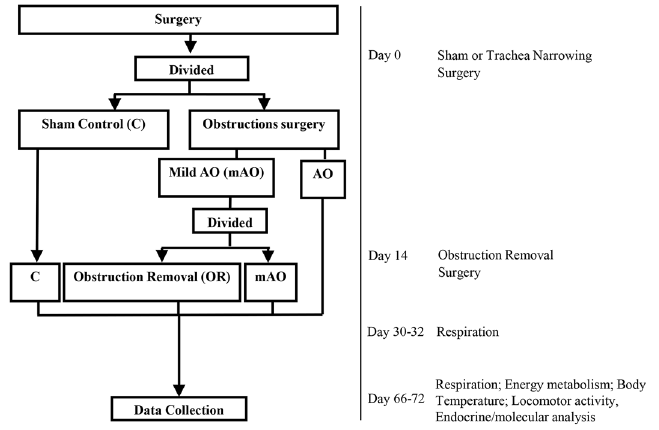
Figure 1. Flow diagram of study groups and time data